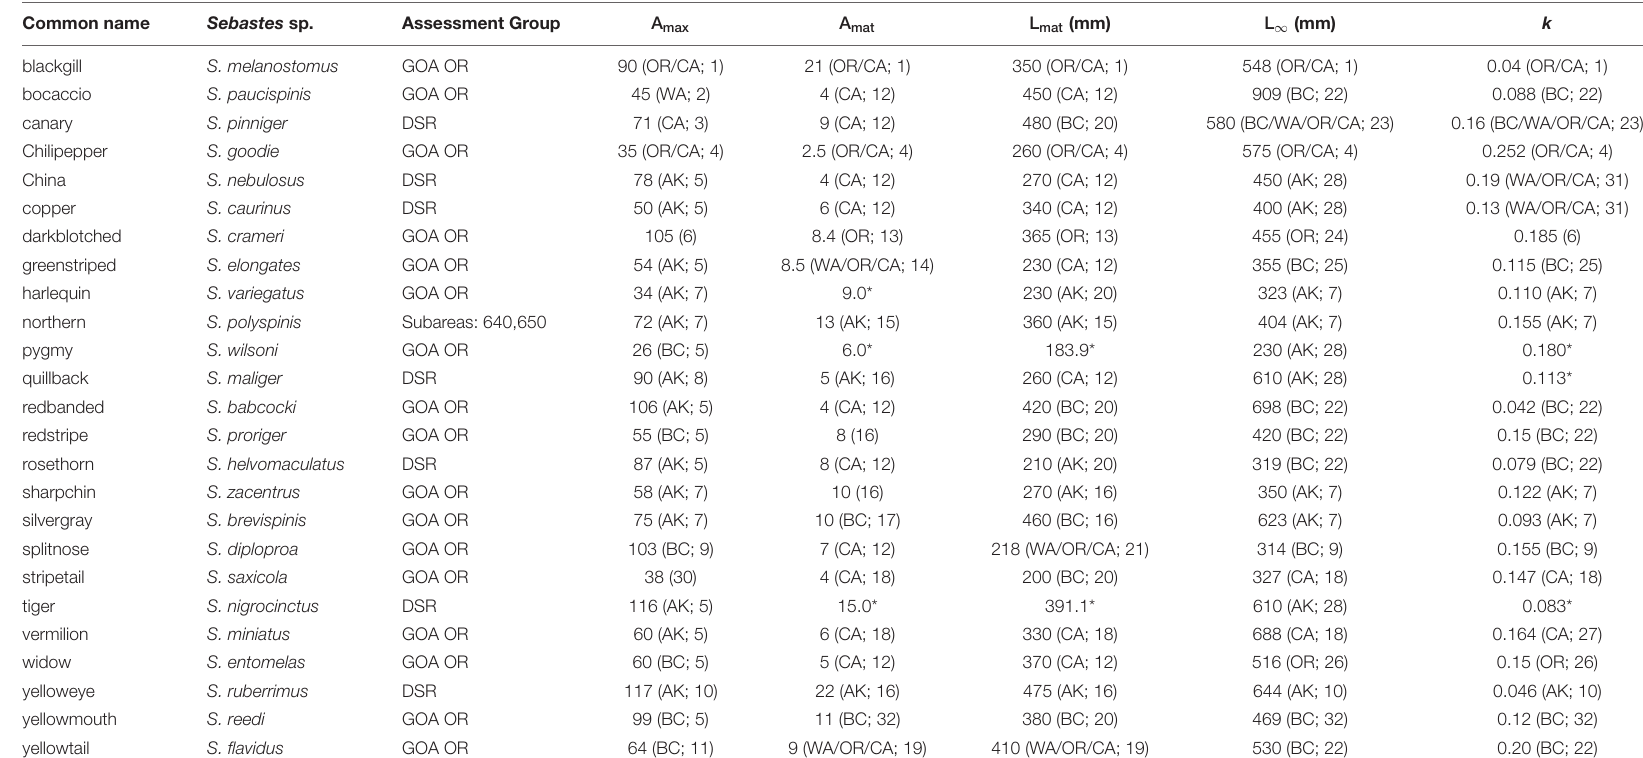
TABLE 1 | Life history characteristics for each Gulf of Alaska Other Rockfish (GOA OR) and Demersal Shelf Rockfish (DSR) species. Common